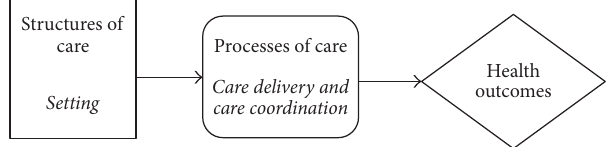
Figure 1: The Donabedian healthcare organisation and delivery model